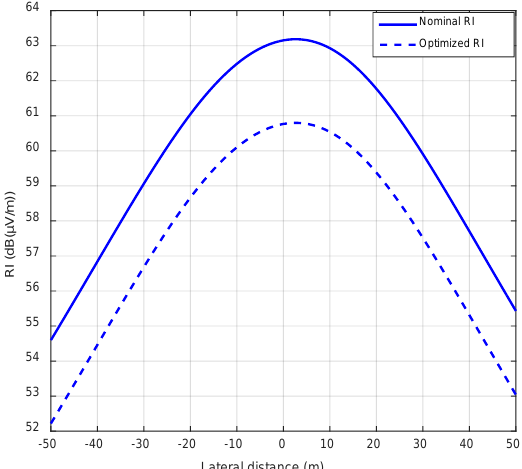
Figure 11. Comparison of nominal and optimized RI lateral profiles for ±600 kV line.